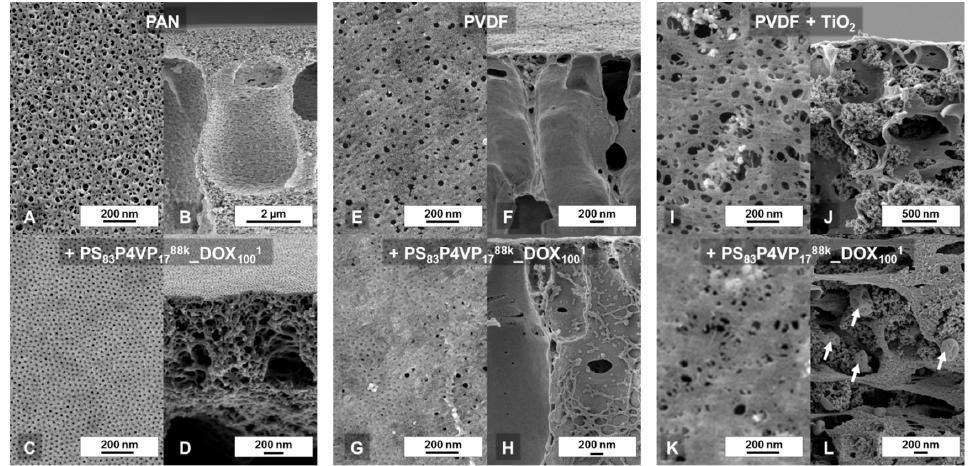
Figure A1. PAN ( A – D ), PVDF ( E – H ) and PVDF + TiO 2 (8 wt.%) ( I – L ) as supporting membrane. The pristine top layer ( A , E , I ) and its cross-sectional view (B,F,J) and the same coated with PS 83 - b -P4VP 17 _DOX 1001 in top layer view ( C , G , K ) and cross-sectional view ( D , H , L